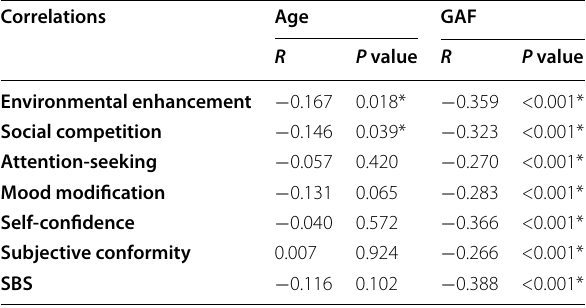
Table 7 correlation between items of Selfie Behavioral Scale (SBS), total score, Age and general assessment of functioning